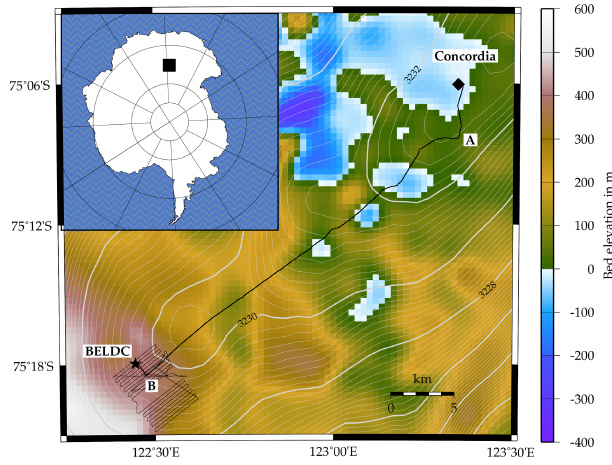
Figure 1. Map of study area, with inset showing location in Antarc- tica. Black lines show radar profiles acquired in 2019, with bold line showing the profile evaluated here. EDC core coincides with Con- cordia. Contours show surface elevation from Helm et al. (2014). Background colors are bed elevation relative to sea level from Bed- Machine Antarctica v2 (Morlighem et al.,